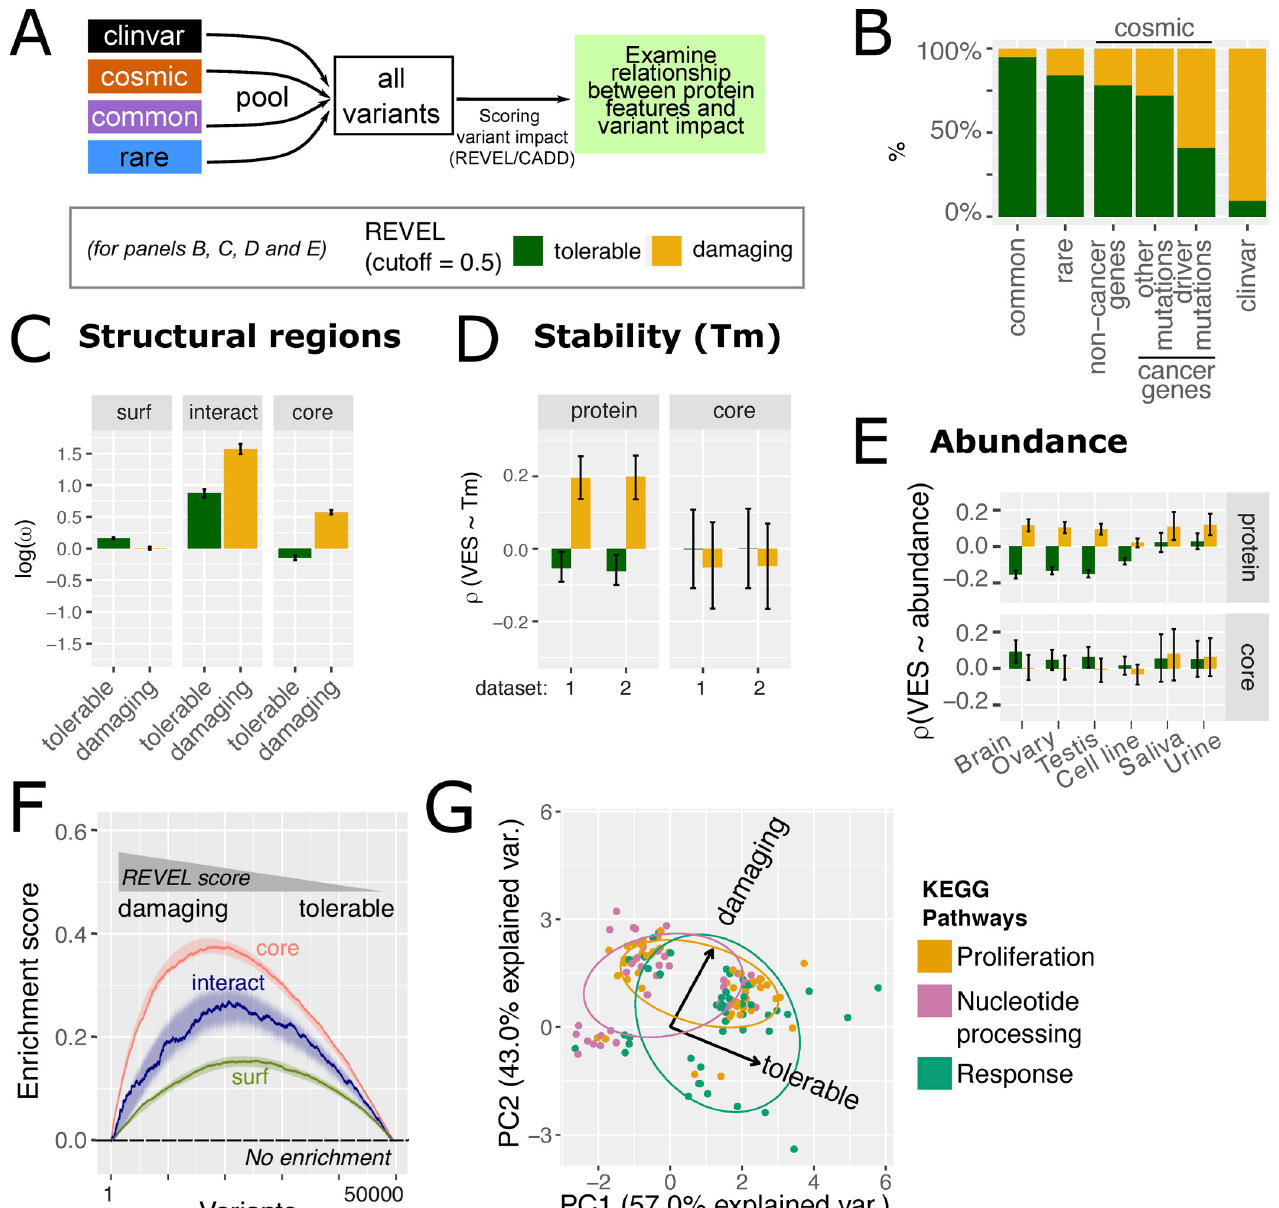
Fig 7. Orthogonal variant impact predictions validate structural and proteomics features. (A) Schematic of pooling variants and annotating variant impact. (B) Breakdown of variant impact classified by REVEL in the variant datasets. For COSMIC variants in cancer genes, variants were segregated depending on whether they are driver mutations (curated in IntoGen [50], version 2016.5). (C) The enrichment of tolerable and damaging variants in different protein structural regions. Variants are annotated using REVEL. The bars represented the median density ( ω , here taken logarithm such that negative values indicate depletion and positive values indicate enrichment) of 1,000 bootstrapped samples, each a subset of 50,000 variants. The error bars represented 95% confidence intervals from such bootstrapping. See S16 Fig for analogous results for CADD. (D–E) The correlation between VES calculated at the whole-protein level (“whole”) and the protein core, with protein stability (panel D, melting temperature or Tm) and abundance (E). Identical to Fig 5 but with the “tolerable” and “damaging” classification under REVEL score. See S17 and S18 Figs for data on CADD, and plots for all tissues represented in the abundance dataset. (F) The enrichment of surface, core, and interacting interface over variants ranked by REVEL score. The enrichment score from the GSEA procedure was plotted here. The absence of enrichment would result in a flat line at 0 (dashed black line). Curves represent data from 1 representative bootstrapped sample; the ribbons indicate 95% bootstrapped confidence intervals. (G) Pathway enrichment analysis for tolerable and damaging variants as defined by REVEL, i.e., underlying data identical to that of panels (B–D). Here, pathway enrichment scores were projected on 2 principal components analogous to Figs 4B and 6. Pathways were categorised using the scheme defined in Fig 4B. See S19 Fig for analogous results for CADD. S13 Data contains underlying data for all panels of this figure. GSEA, Gene Set Enrichment Analysis; Tm, melting temperature; VES, Variant Enrichment Score.